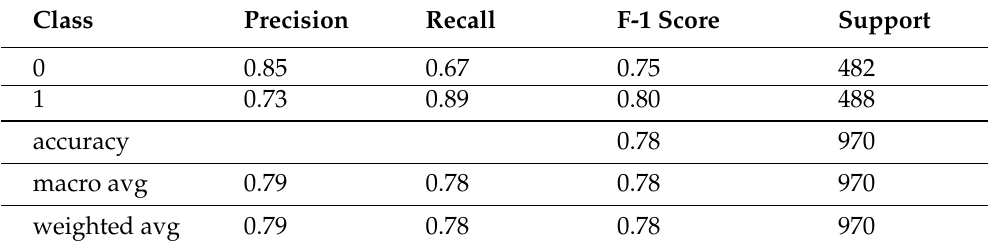
Table 6. Classification report for BoW with XGBoost.